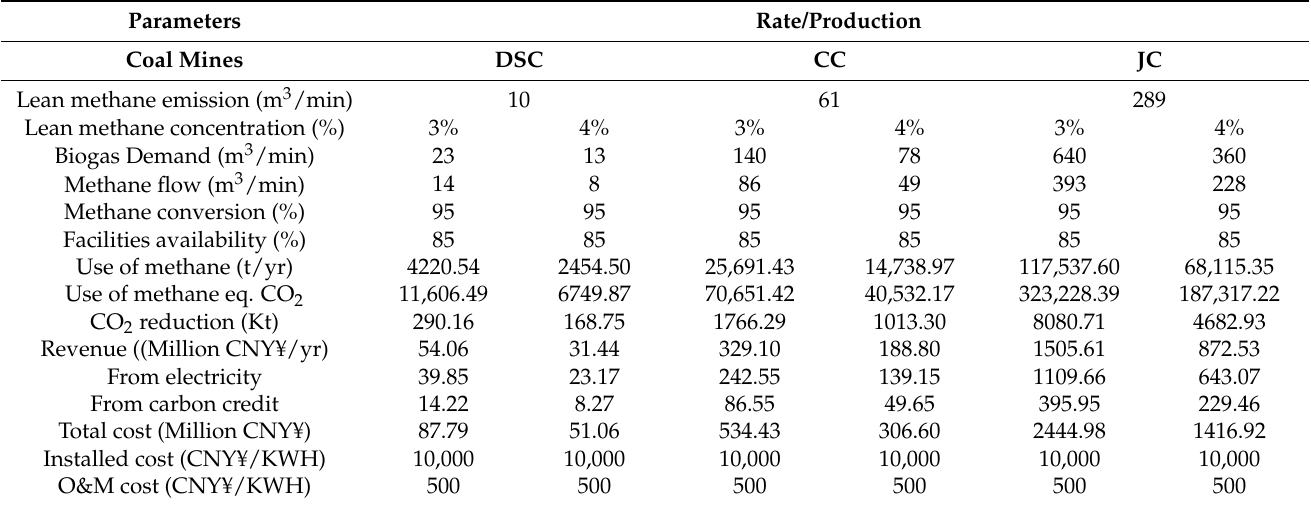
Table 4. Economic and environmental analysis by using lean methane and biogas in the co-production